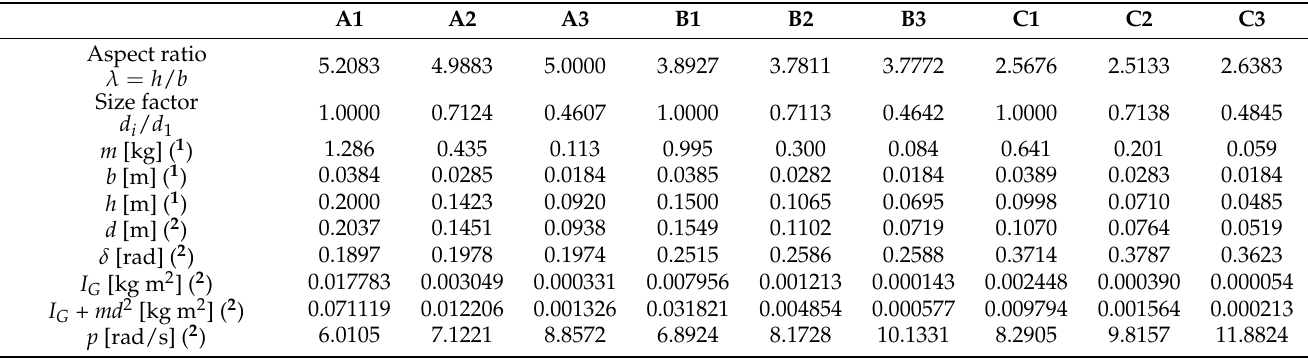
specimens and values ( 2 ) indirectly obtained from theoretical formulation.